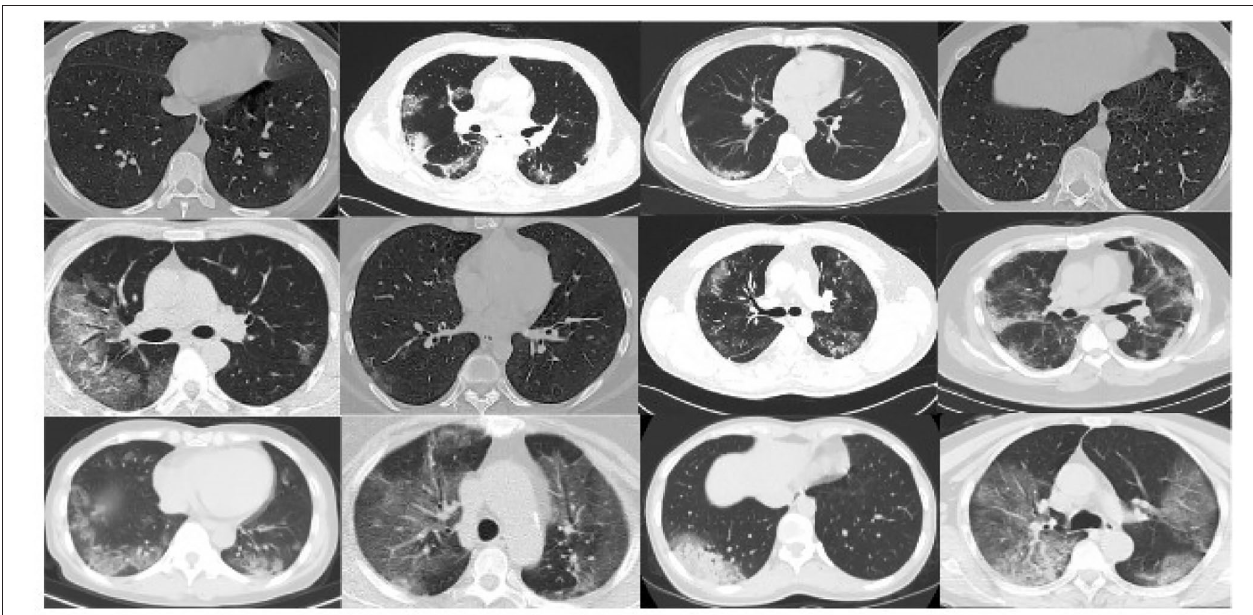
FIGURE 3 | Computed tomography specimen images—Datasets 2 &